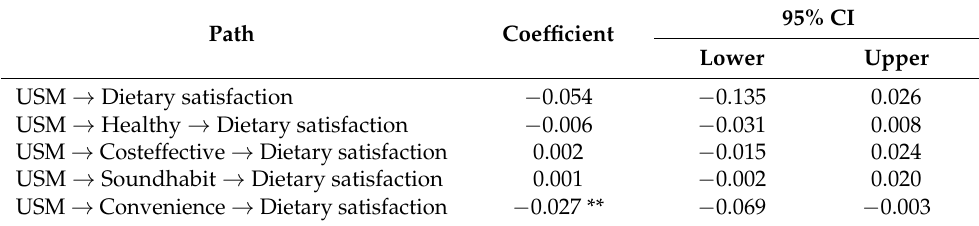
Table 6. Analytic result of